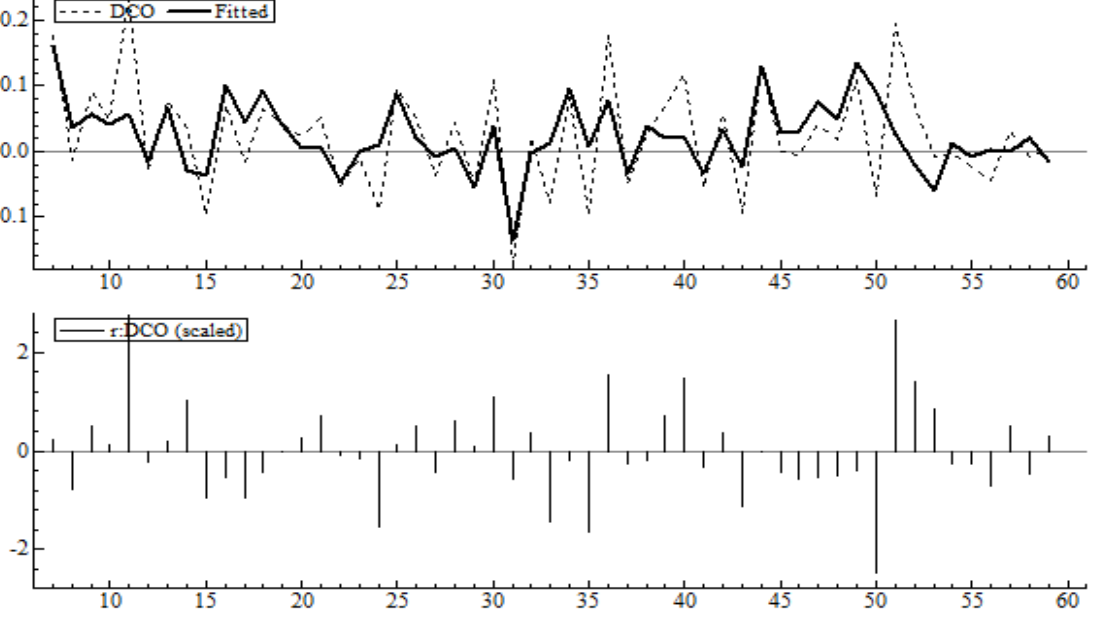
Figure 6. Results for the short-term model of CO 2 emissions (Norway): See Equation (5). Fitted model top graph; residuals bottom graph.